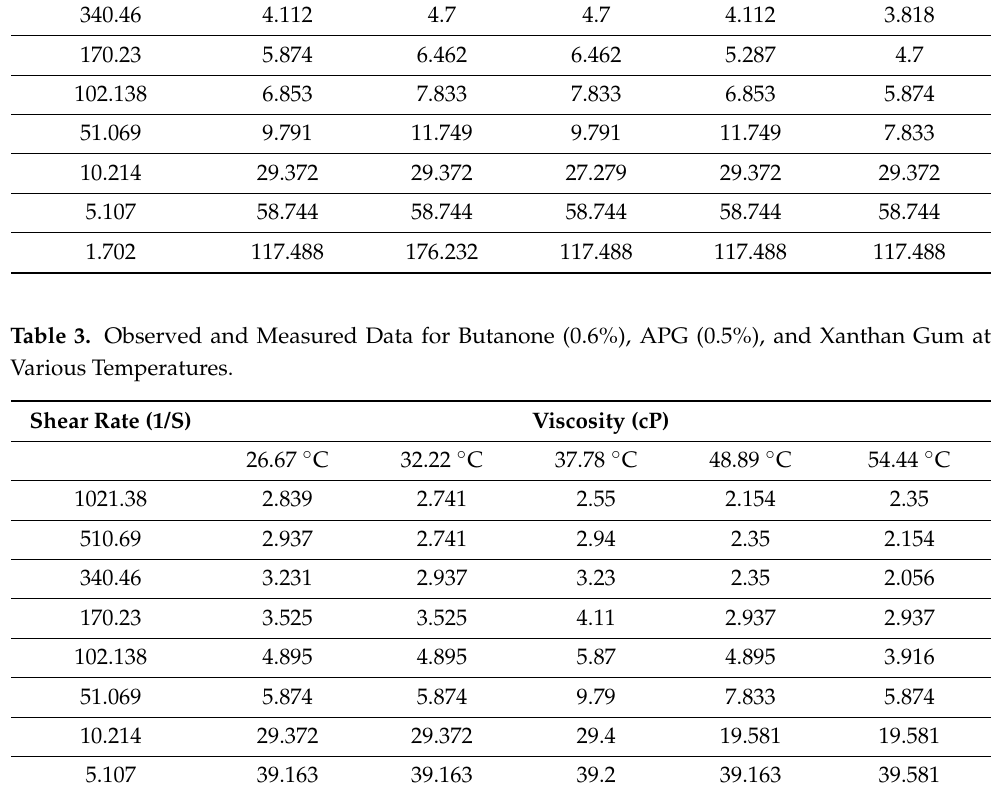
Table 2. Observed and Measure Data for Acetone (0.6%), APG (0.5%), and Xanthan Gum at Vari- ous Temperatures.